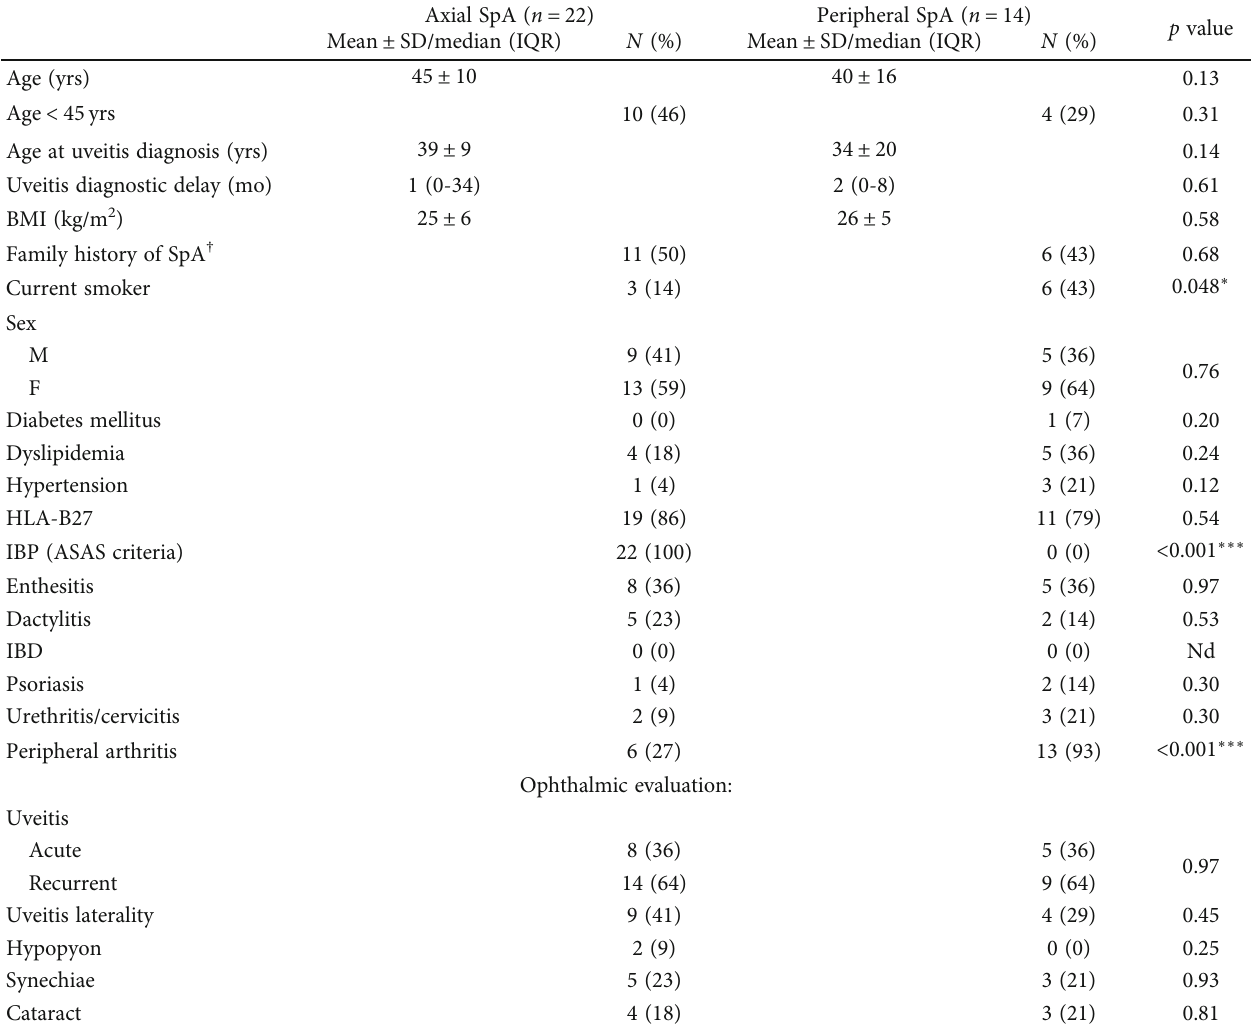
Table 4: Main characteristics of study population according to SpA classi fi